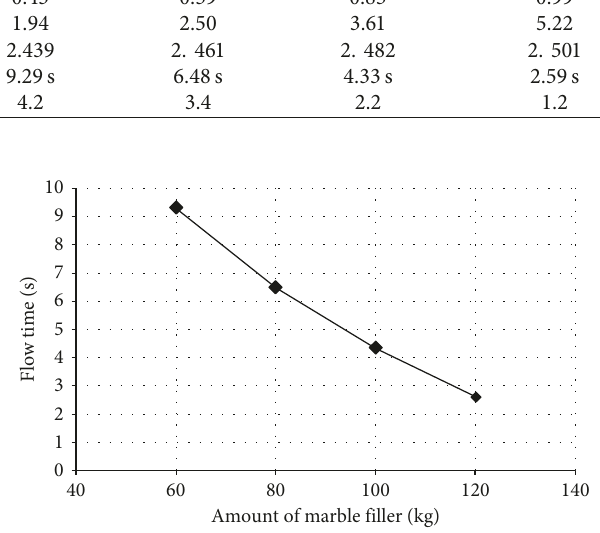
Figure 4: Flow time value as function of MP